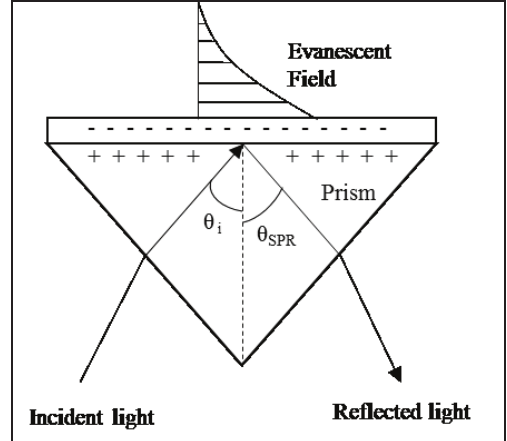
Fig. 2. The presence of evanescent field after light undergo total internal reflection [16].